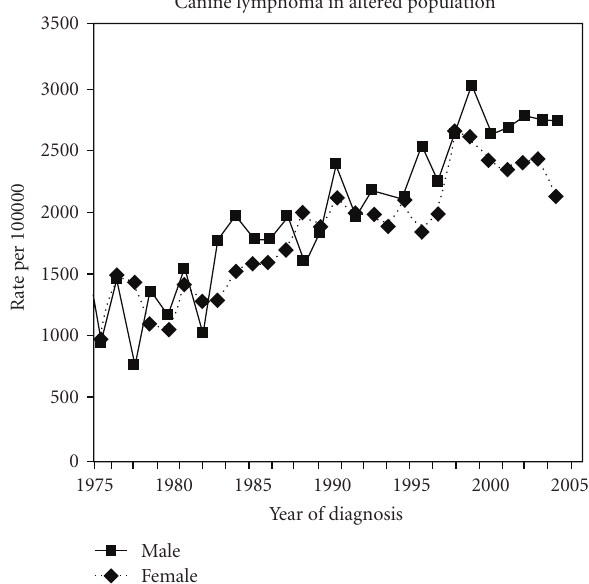
Figure 2: Rate of lymphoma in the intact canine population in the VMDB. Dashed line represents female intact (FI) dogs and solid line represents male intact (MI) dogs.